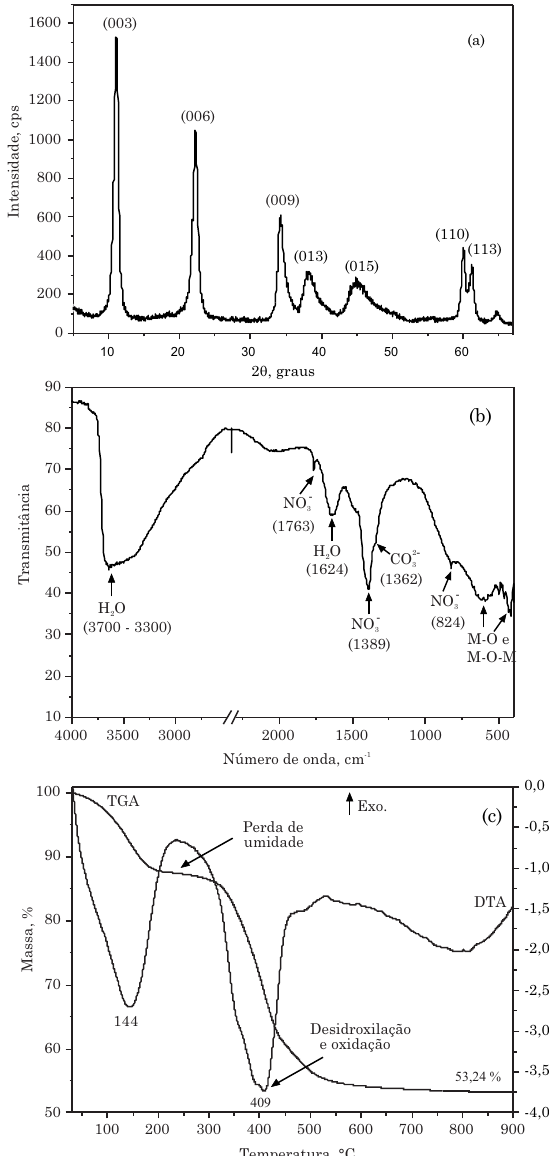
Figura 1. Caracterização do hidróxido duplo lamelar - HDL-Mg 5 Al 1 : (a) difratograma de raios-X; (b) espectro vibracional na região do infravermelho com transformada de Fourier; e (c) curvas da análise térmica (análise termogravimétrica - TGA e da análise térmica diferencial -